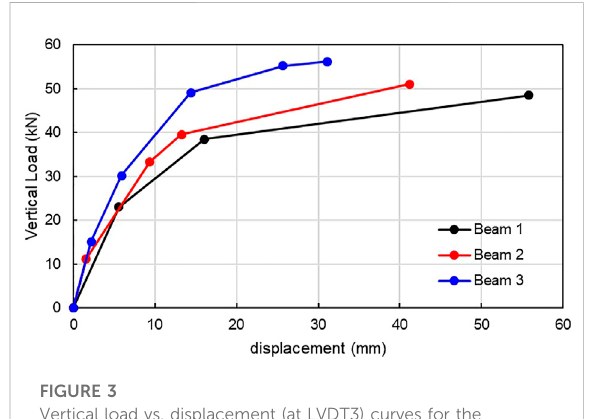
FIGURE 3 Vertical load vs. displacement (at LVDT3) curves for the laboratory PTC beams.